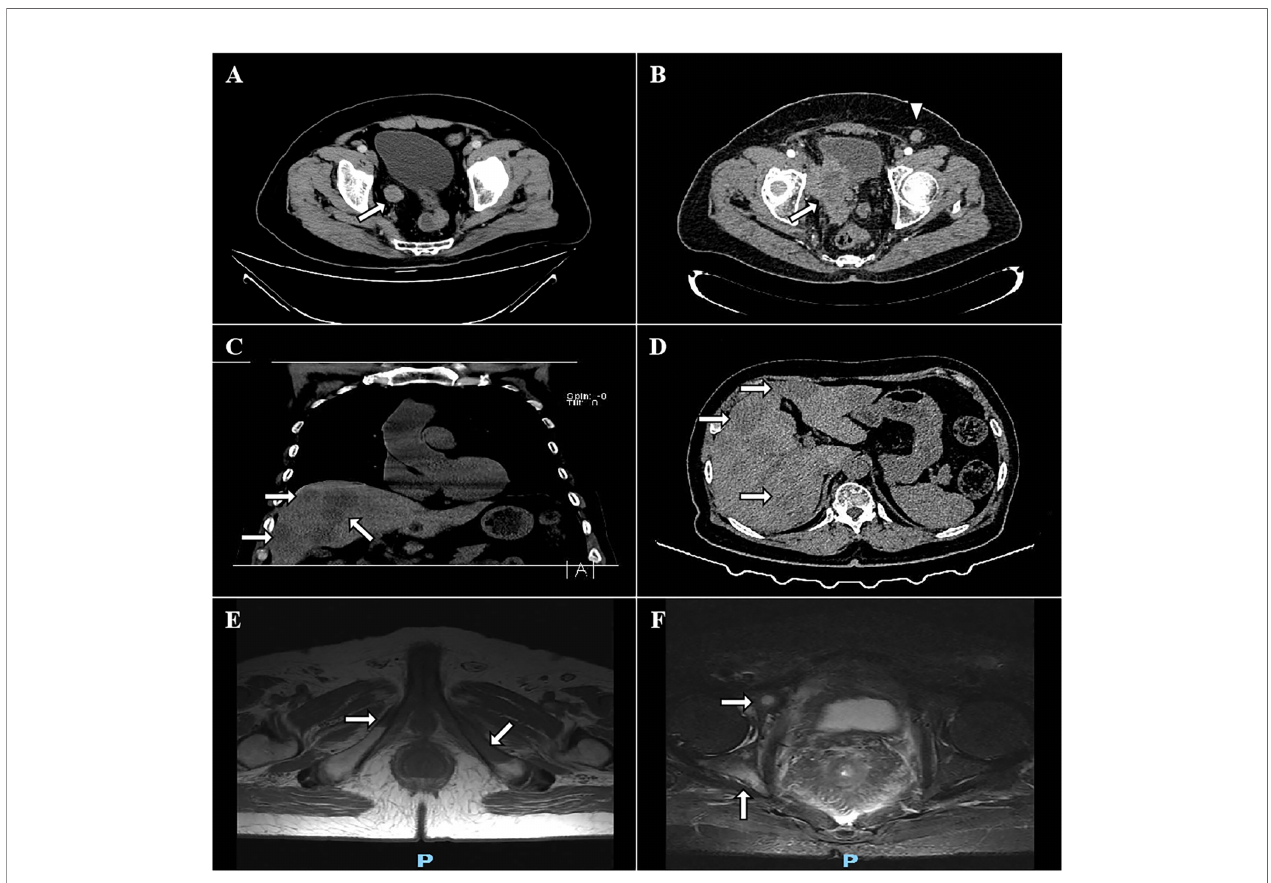
FIGURE 1 | CT and MRI images of the mass. The preoperative transverse view reveals that the tumor was located in the lower segment of the right ureter (A) . CT scan reveals local relapse in the tumor bed with in fi ltration to the surrounding tissues (white arrow, B ). Left inguinal lymphadenopathy (2.1x1.5 cm, white triangle, B ). Coronal and transverse views show a progressive SCNEC with multiple liver (C, D) , bilateral pubic bones (E) , and right acetabulum (F) metastases after 2 cycles of